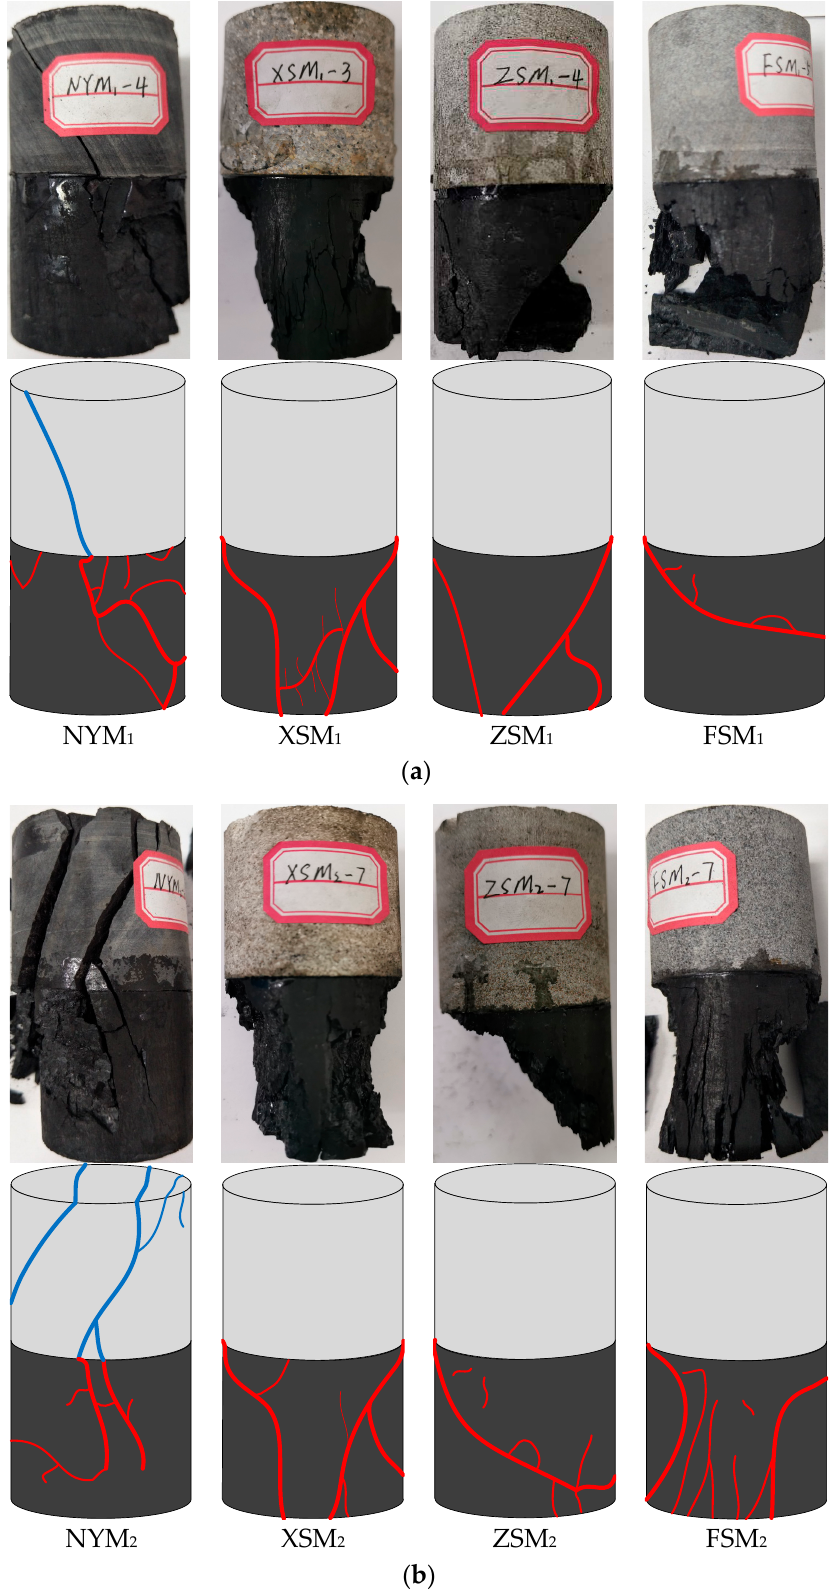
Figure 8. the typical failure modes of the CRC specimens: ( a ) #1CRC specimens; ( b ) #2CRC specimens.